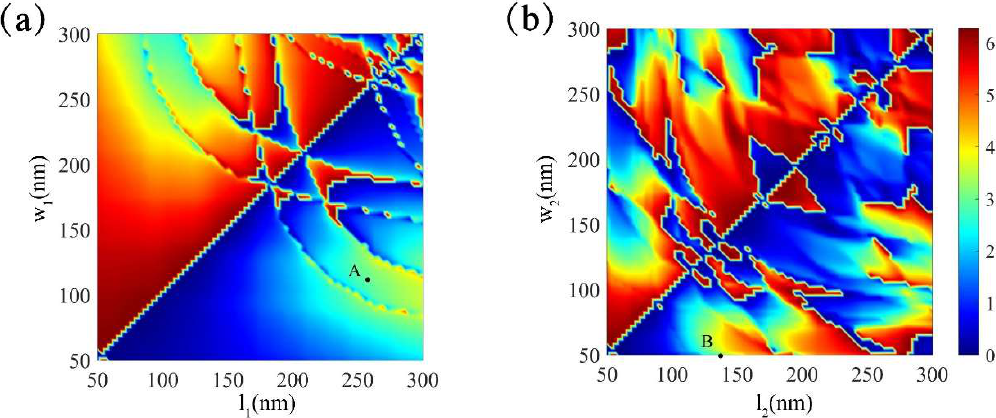
Figure 3. The phase shift difference (∆φ) of linearly polarized light along ordinary axes and extraordinary axes with different lengths of ordinary axes (l 1 , l 2 ) and extraordinary axes (w 1 , w 2 ) for ( a ) BTO nanofin and ( b ) Si nanofin.